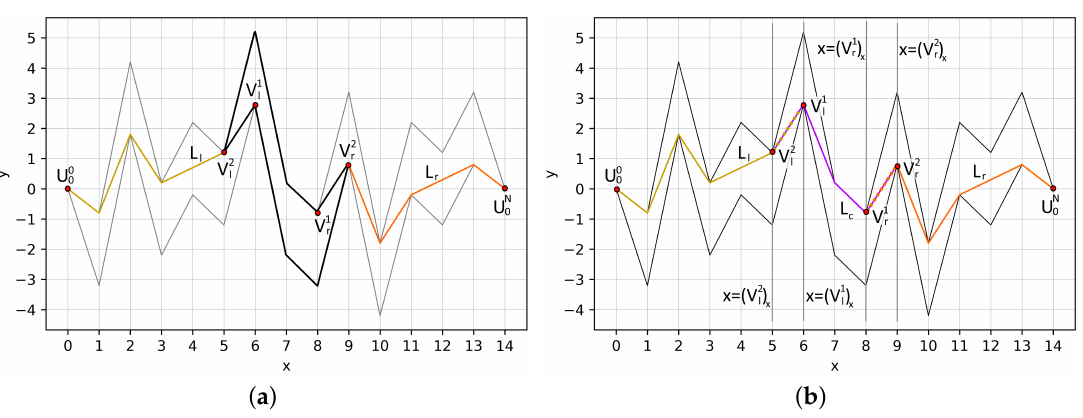
Figure 12. ( a ) Central subtube T c (black); ( b ) part of the extremal curve L c (purple) between vertices V 2 and V 1 coincides with corresponding part of the curve L l , part of the extremal curve L c (purple) l l between vertices V 1 r and V 2 r coincides with correspondent part of the curve L l .